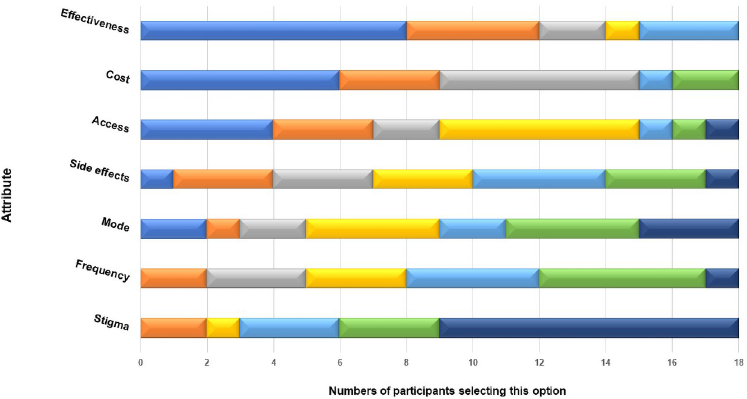
Fig 2. Ranking of PrEP attributes among 18 young MSM during in-depth interviews in Upstate NY. 1st Rank: Medium Blue. 2nd Rank: Orange. 3rd Rank: Gray. 4th Rank: Yellow. 5th rank: Light Blue. 6th rank: Green. 7th Rank: Dark